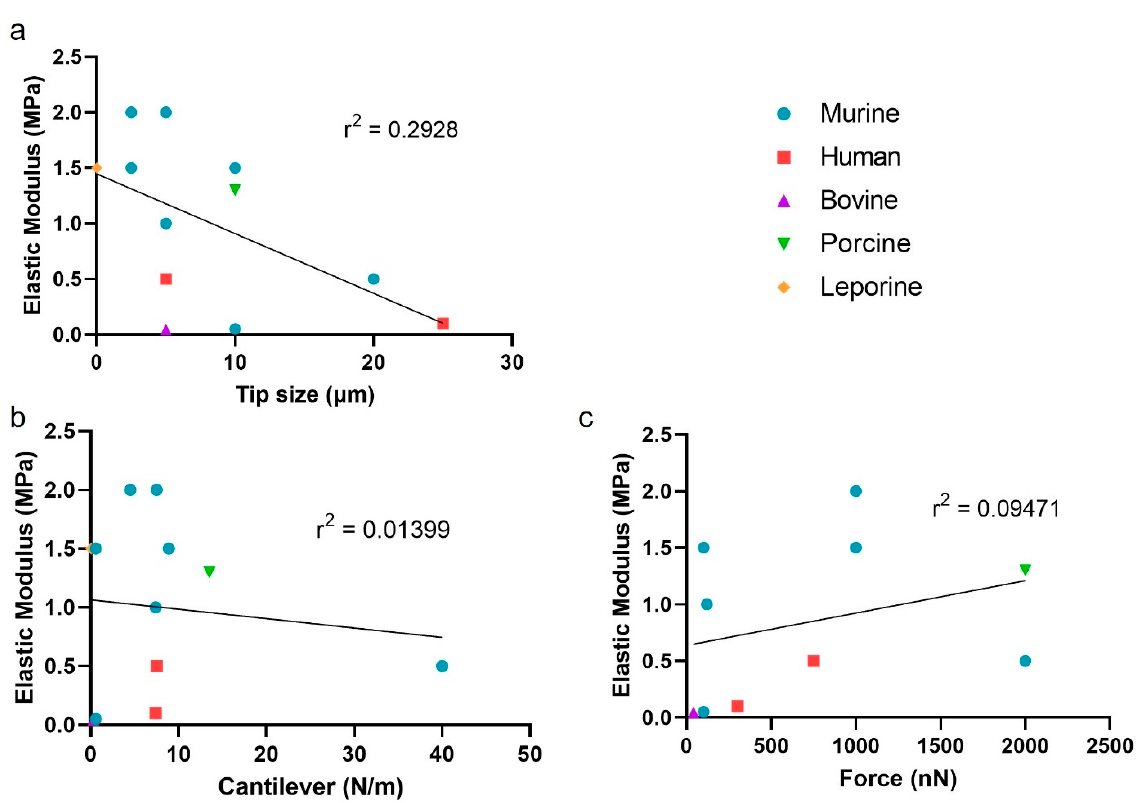
Figure 3. Published relationships between experimental parameters (tip size, cantilever stiffness, indentation force) and reported elastic moduli of articular cartilage. ( a ) Relationship between tip size and measured stiffness of articular cartilage. ( b ) Relationship between cantilever stiffness and measured elastic modulus. ( c ) Relationship between force and measured elastic modulus.